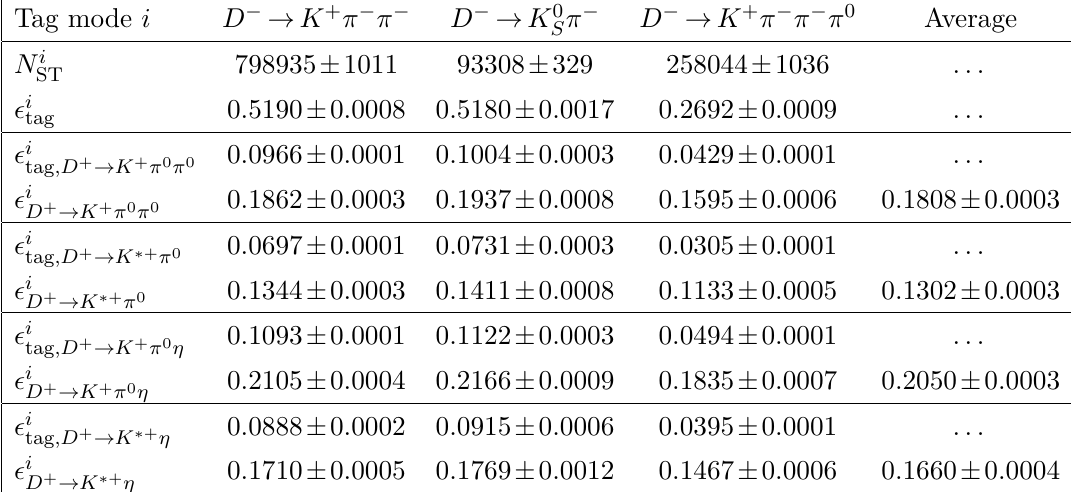
), the ST efficiencies ( (cid:15) i ), the DT efficiencies ( (cid:15) i = (cid:15) i ), and Table 1 . The ST yields ( N i tag tag , sig ST DT the signal efficiencies ( (cid:15) i ). Compared to the mixed signal MC events, the lower signal efficiencies sig for the resonant decays are mainly due to that the π 0 s from K ∗ + decays have much lower momenta and an additional K ∗ + mass requirement. For D − → K + π − π − π 0 , the efficiencies are lower than those of the other two tag modes, mainly because of more migrations of low momentum pions between tag and signal sides. The efficiencies do not include the BFs of subresonance decays. The uncertainties are statistical